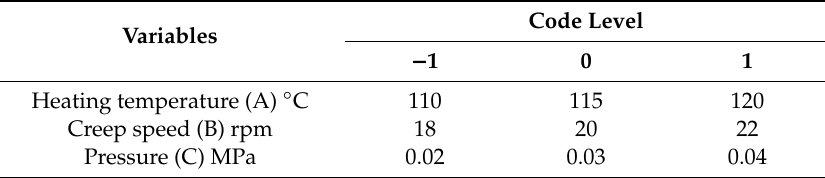
Table 4. Coded levels of temperature, creep speed and